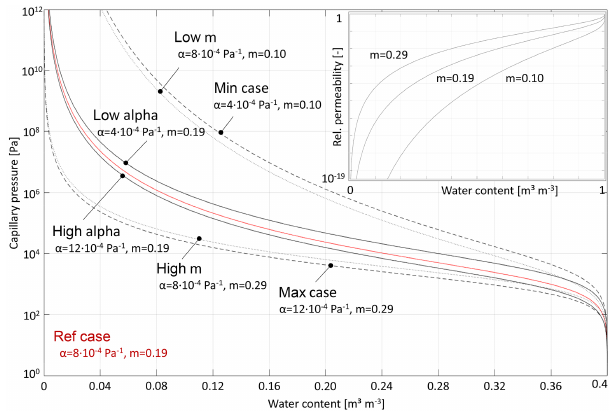
Figure 2. Retention curves S ∗ described by the van Genuchten model (Eq. 2) and as used in the different model scenarios; resid- ual saturation set to zero for all cases. (Inset) Relative permeability described by the Mualem model (Eq.